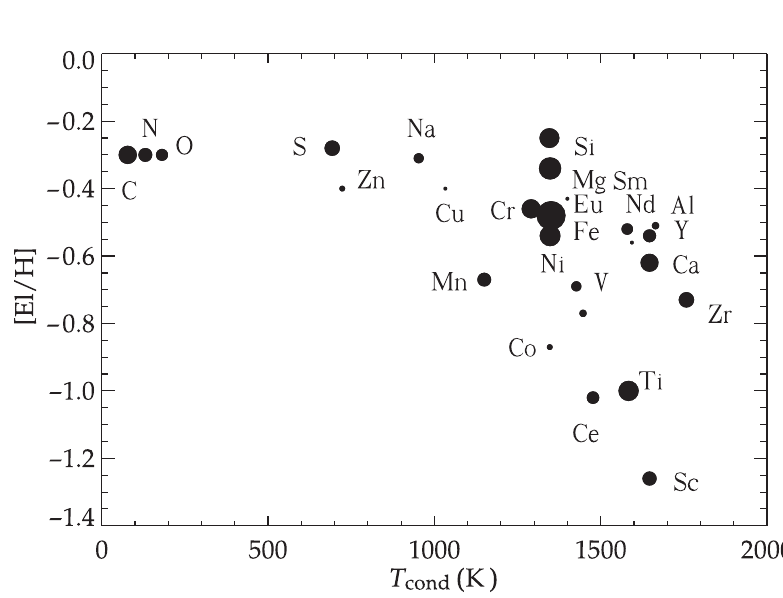
Fig. 4. The abundances of elements in 89 Her versus their condensation temperature. The symbol diameters are proportional to the logarithm of the number of spectral lines used (ln N lines ). Two elements, Nd and Eu are represented only by one